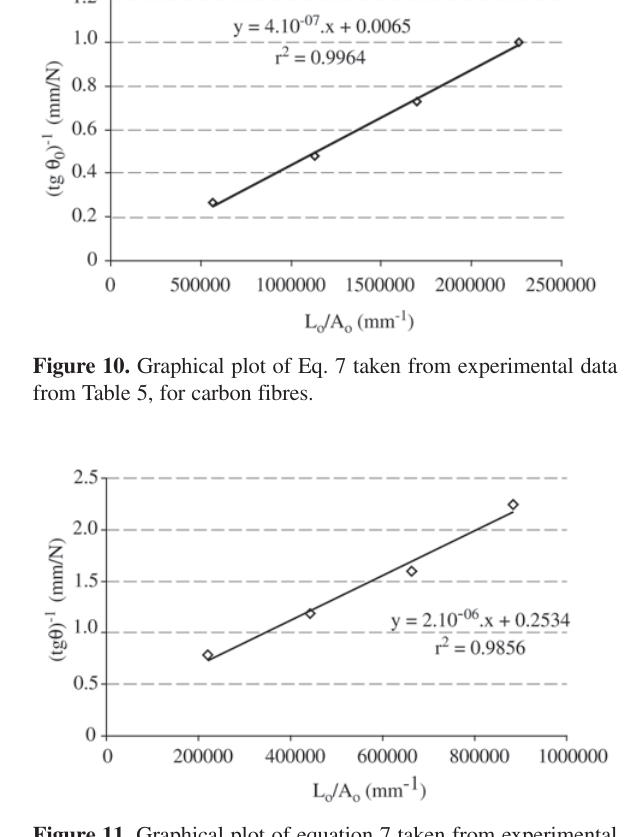
Table 5. Results for (tg θ